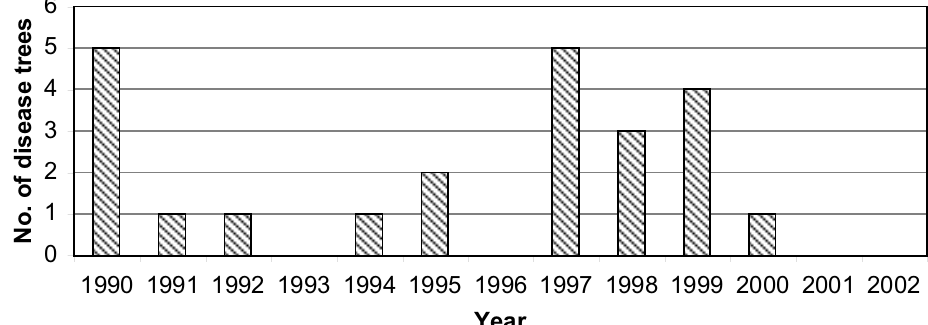
Fig. 2. Number of sharka-infected apricot trees in the orchard studied from 1990 to 2002.